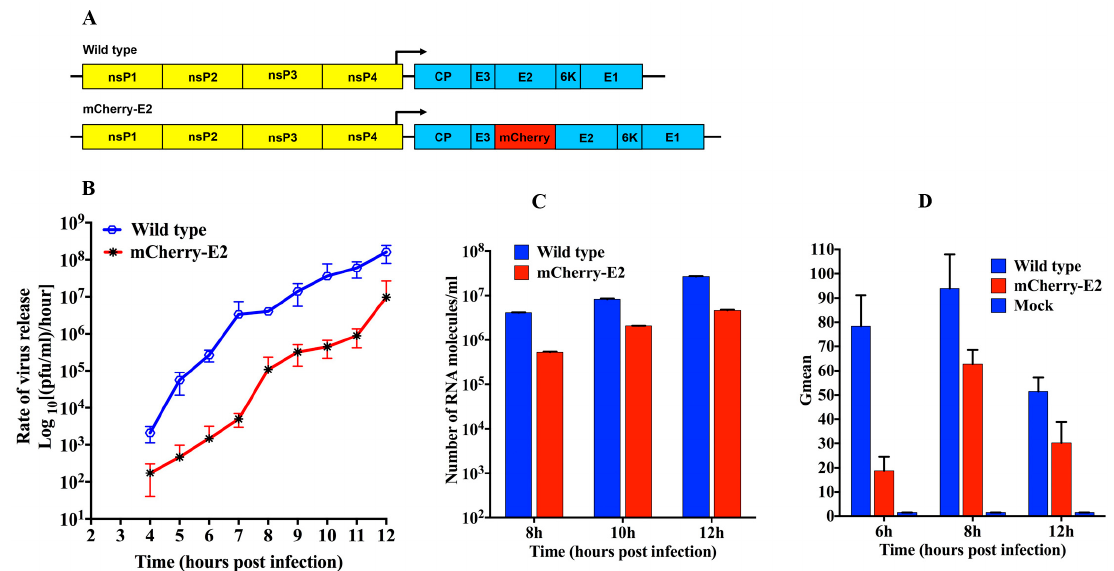
Figure 1. Construction and characterization of mCherry ‐ tagged virus. ( A ) Schematic of wild ‐ type (WT) and mCherry ‐ E2 Sindbis virus (SINV) complementary DNA (cDNA) clones; ( B ) One ‐ step growth curve analysis of WT and mCherry ‐ E2 virus released from Baby Hamster Kidney fibroblast (BHK) cells. BHK cells were infected with WT or mCherry ‐ E2 viruses at a multiplicity of infection (MOI) of 5 and media were changed every hour for 12 h and the rate of virus release (plaque ‐ forming unit (pfu) per ml per hour) was determined using standard plaque assays; ( C ) Quantitation of the number of viral RNA molecules (corresponding to virus particles released into the media) for WT and mCherry ‐ E2 mutant viruses at 8, 10, and 12 h. Total number of genome RNA molecules was determined by quantitative real ‐ time reverse transcription PCR (qRT ‐ PCR) using a standard curve of known amount of in vitro transcribed SINV RNA molecules; ( D ) Determination of E2 surface expression in BHK cells infected with WT or mCherry ‐ E2 virus by flow cytometry using anti ‐ E2 monoclonal antibody at 6, 8, and 12 h post ‐ infection (p.i). Y ‐ axis is represented by Gmean, which corresponds to the geometric mean of the fluorescence data calculated by averaging the log of the fluorescence and the scale value of that average in fluorescence units.